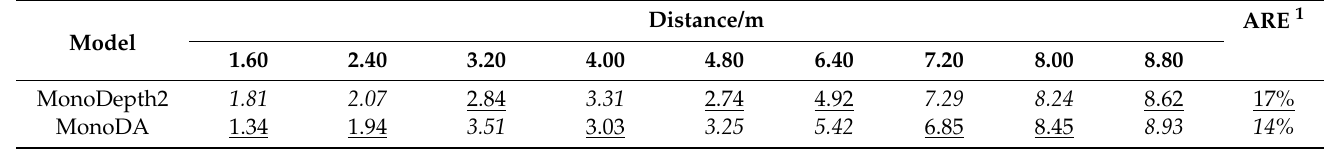
Table 4. Results of estimated distance and comparison with actual